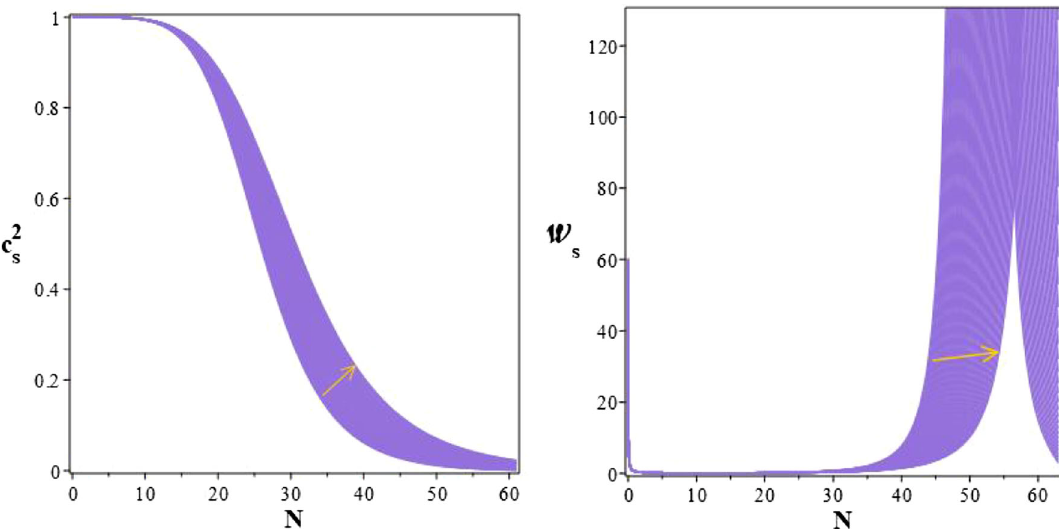
Fig. 2 Theevolutionof c 2 s and W s oftheintermediateMDBImodelversusthee-foldsnumberduringinflation,with b = 10and0 . 340 < β < 0 .